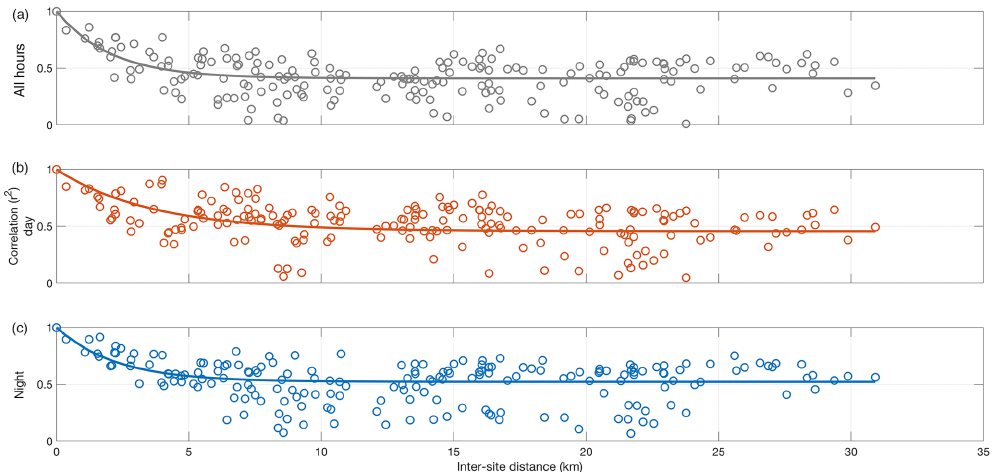
Figure 2. Optimal correlation coefficients for every possible pairing of summer 2017 sites as a function of their separation distance during all hours (a) , daytime hours (11:00–18:00LT, b ), and nighttime hours (21:00–04:00LT, c ). Solid lines show exponential decay of the correlation coefficients.